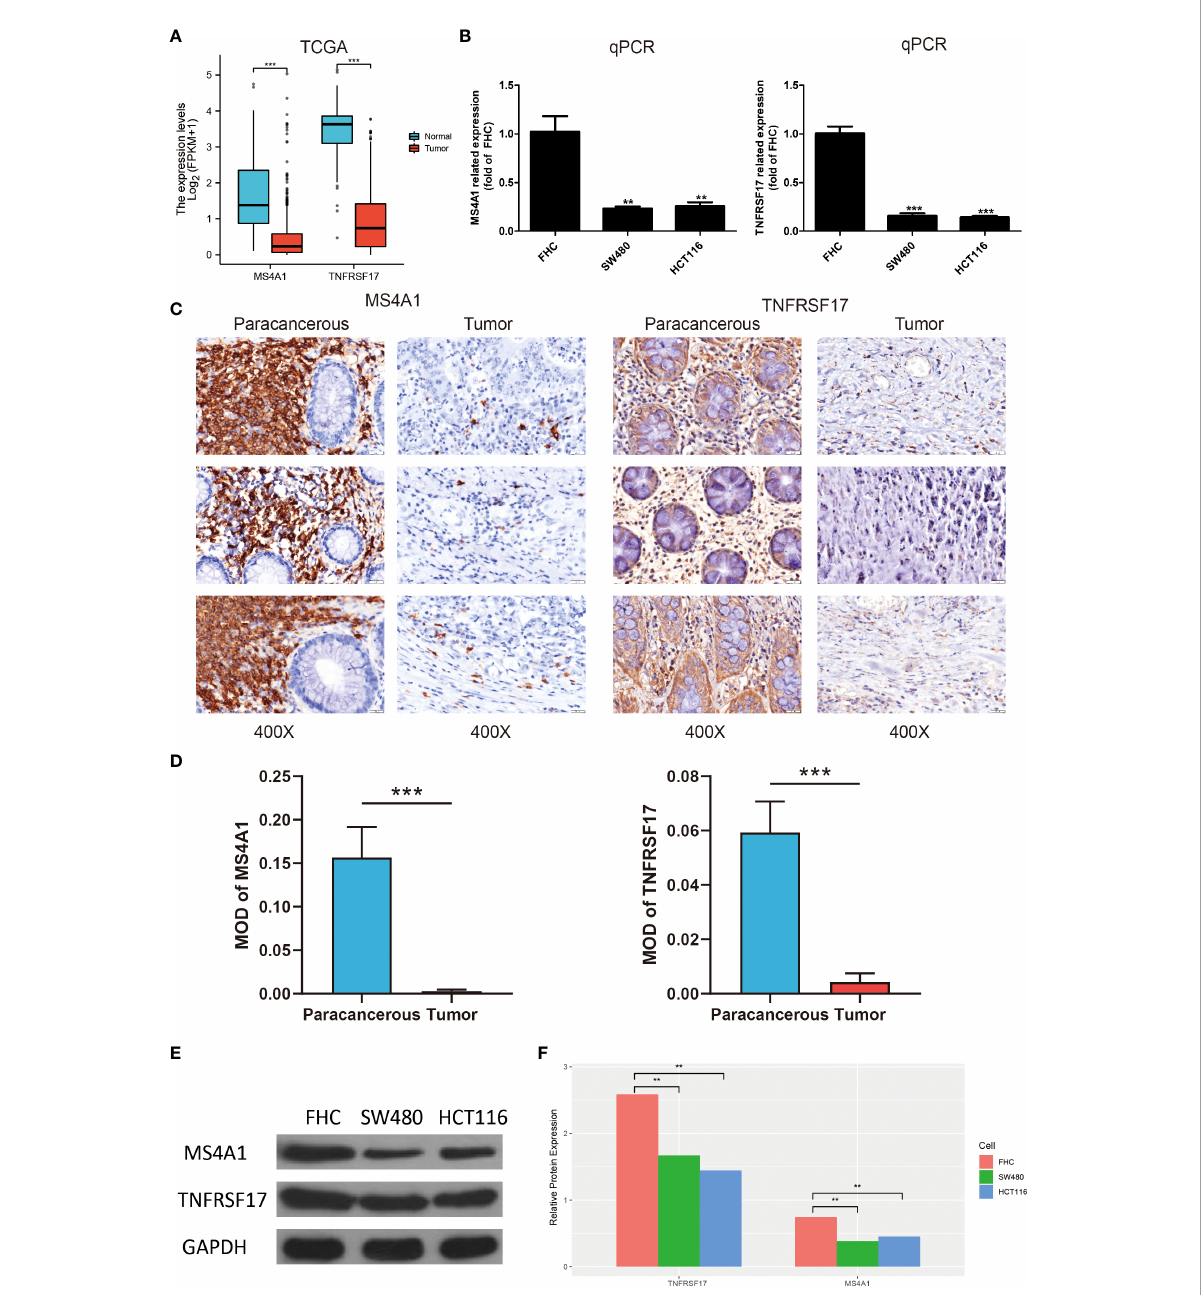
FIGURE 4 Expression of MS4A1 and TNFRSF is lower in colon cancer (CC) and related to clinical features. (A) Expression of MS4A1 and TNFRSF17 at the transcription level was lower in colon cancer (CC) tissues than in healthy colon tissues. (B) qRT-PCR showed that the mRNA expression of MS4A1 and TNFRSF17 was higher in FHC cells than in SW480 and HCT116 cells. (C) Matched pairs of CC tissues and adjacent non-neoplastic colon tissues were stained with MS4A1- and TNFRSF17-speci fi c antibodies for immunohistochemical analysis. Representative images of tissues and tumour-in fi ltrating cells are shown (scale bar = 20 m m). (D) The MOD of MS4A1 and TNFRSF17 is obtained by analysing the photo optical density with IPP software. (E, F) Western blotting revealed that the protein expression of MS4A1 and TNFRSF17 was higher in FHC cells than in SW480 and HCT116 cells. **,<0.01;